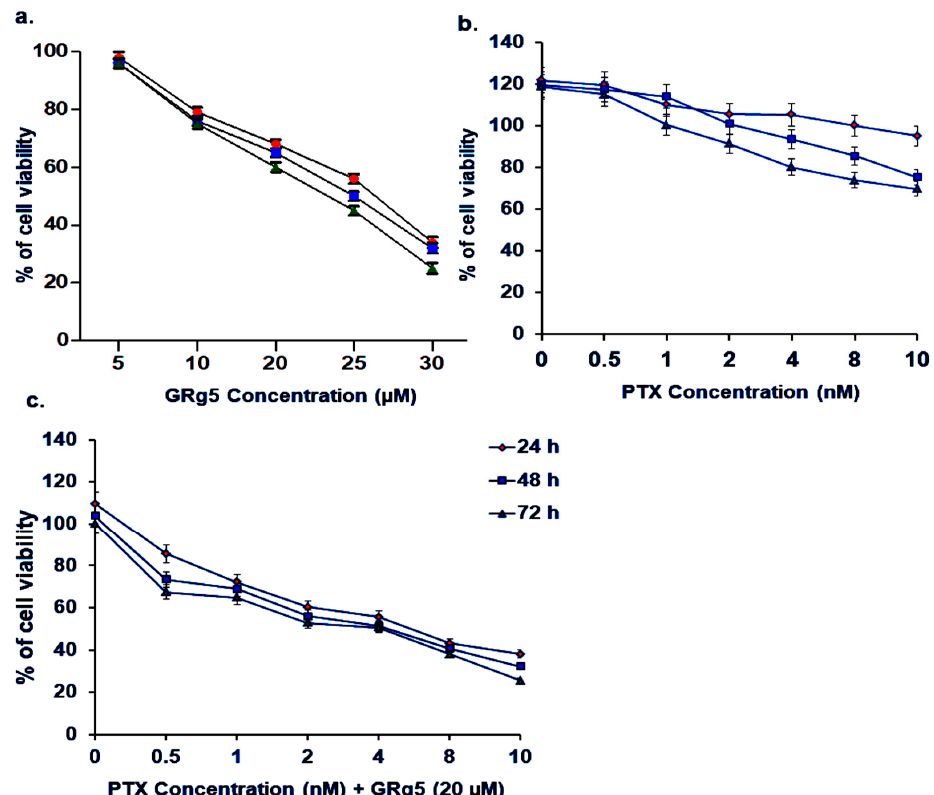
Figure 1. MTT cell proliferation assay: The representative line diagrams showing the cell viability of HeLa-PTX-R cells after treatment with ( a ) GRg5 (5, 10, 20, 25, 30 µ M) with varied concentration for initial screening ( b ) PTX (0, 0.5, 1, 2, 4, and 8 nM) and ( c ) GRg5 20 μ M combined with PTX (0, 0.5, 1, 2, 4, 8 nM) to analyze the best synergetic combination for 24 h, 48 h and 72 h. The absorbance of the samples was measured at a wavelength of 490 nm. Each value is mean ± S.E.M of three individual experiments and the data was normalized with the control group.